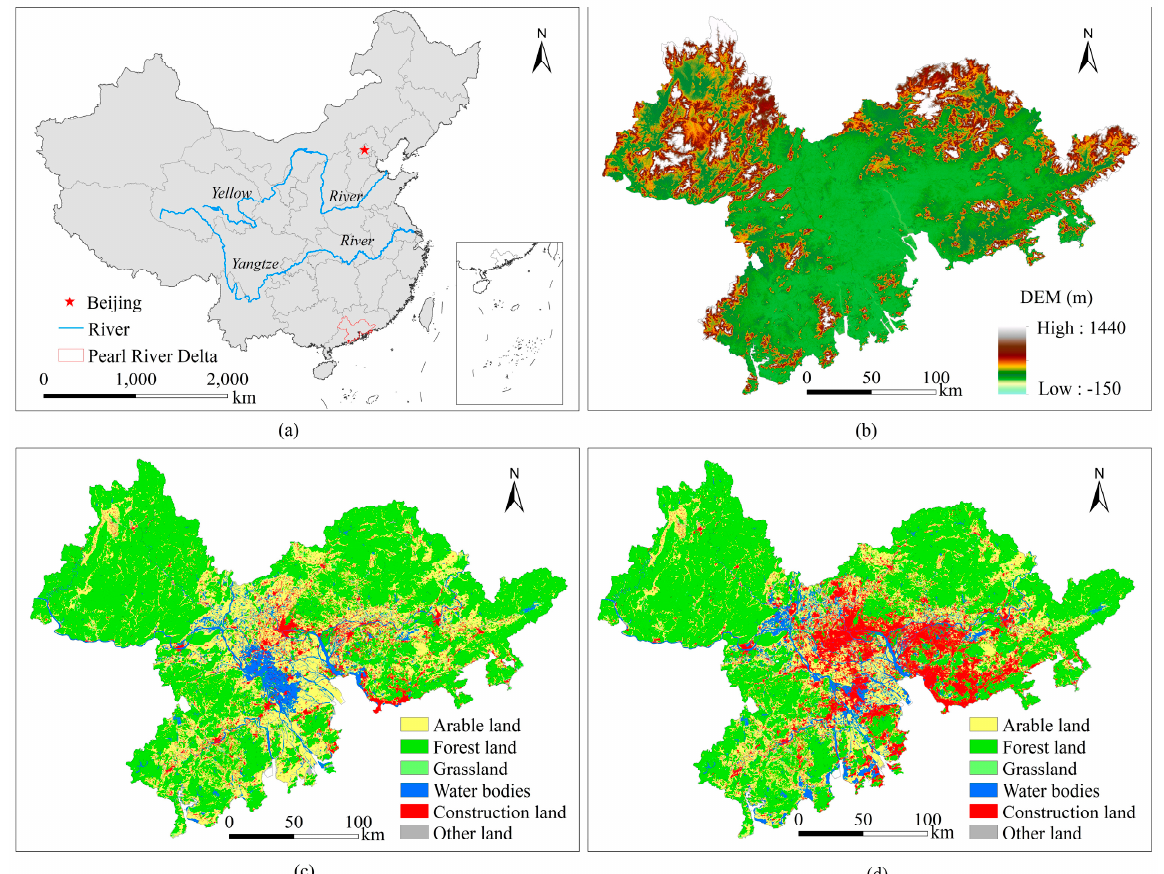
Figure 1. Geographic location ( a ), digital elevation model ( b ), and land use types in 1990 ( c ) and 2015 ( d ) for the Pearl River